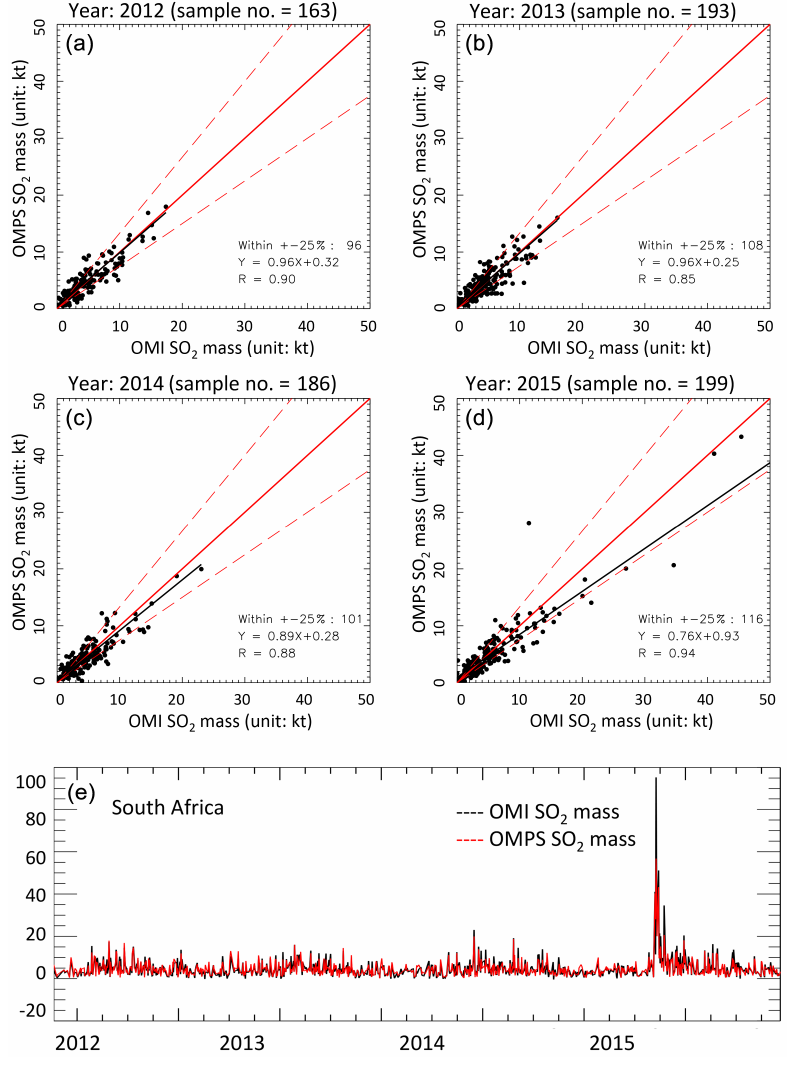
Figure 5. Same as Fig. 3 but for the South Africa region.